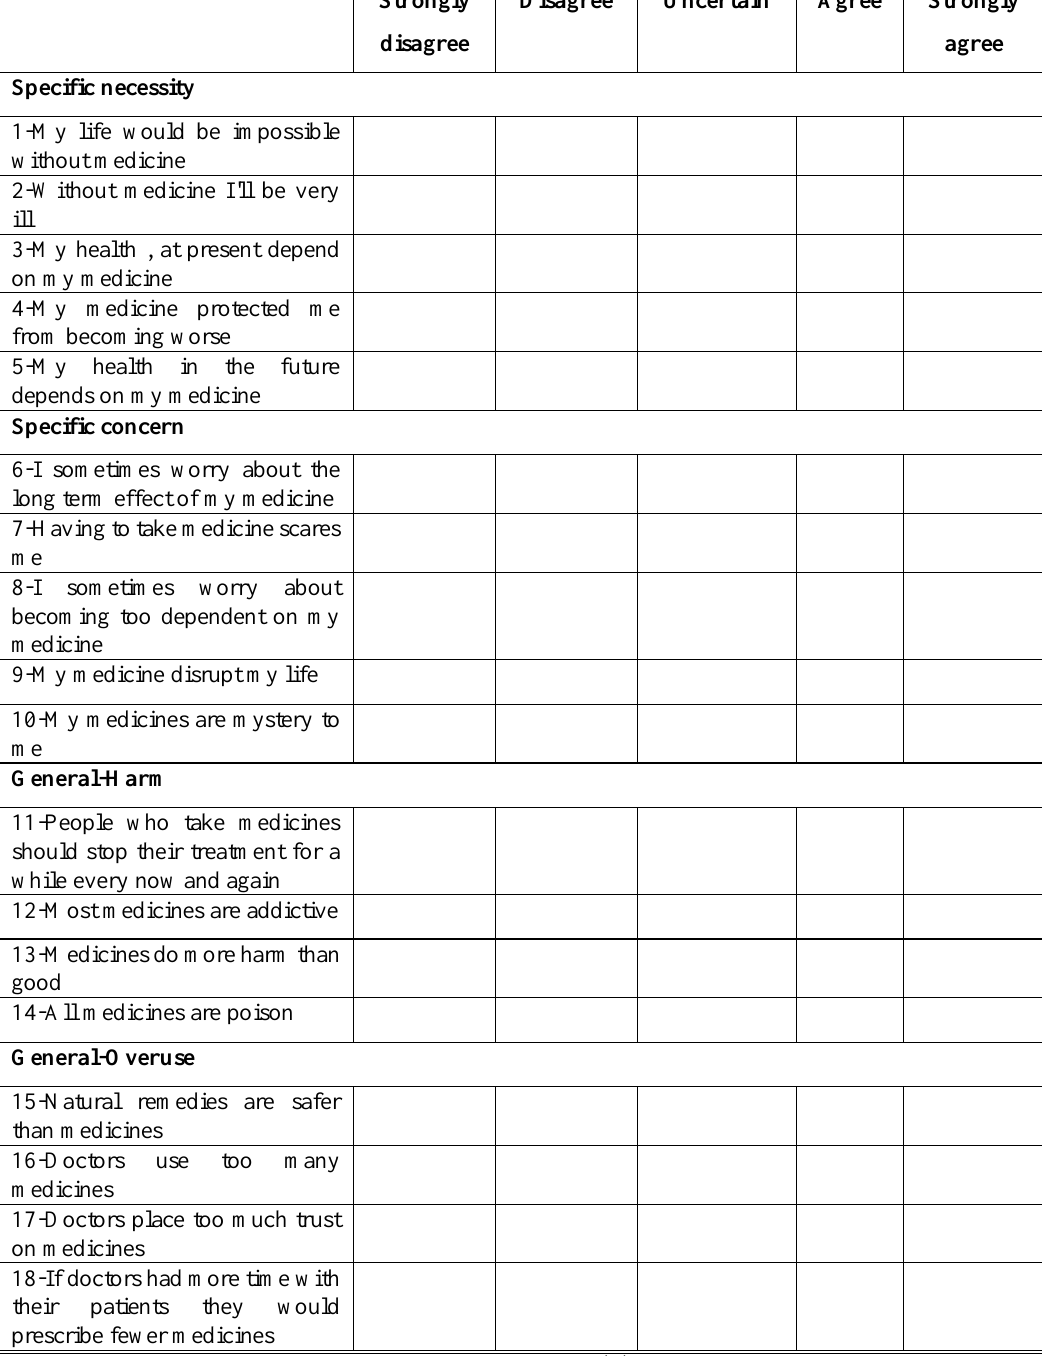
Figure 1. The beliefs about medicines questionnaire (BMQ) (17)